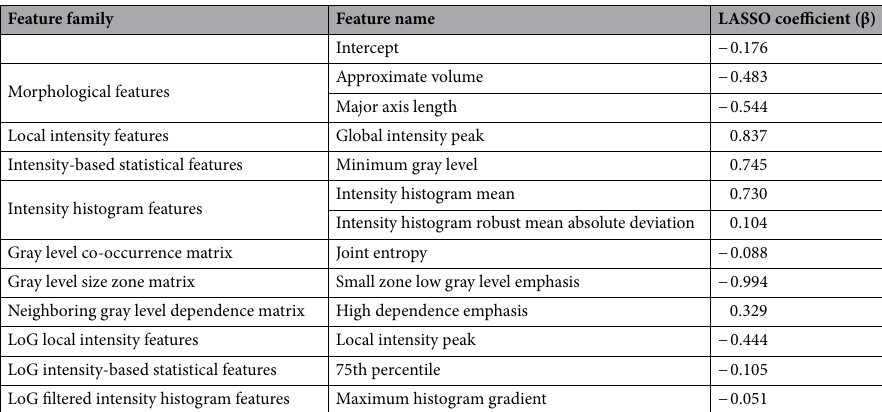
Table 4. List of 12 radiomics features used to develop a radiomics model to predict malignancy of fracture. LoG indicates Laplacian of Gaussian Filtered features.